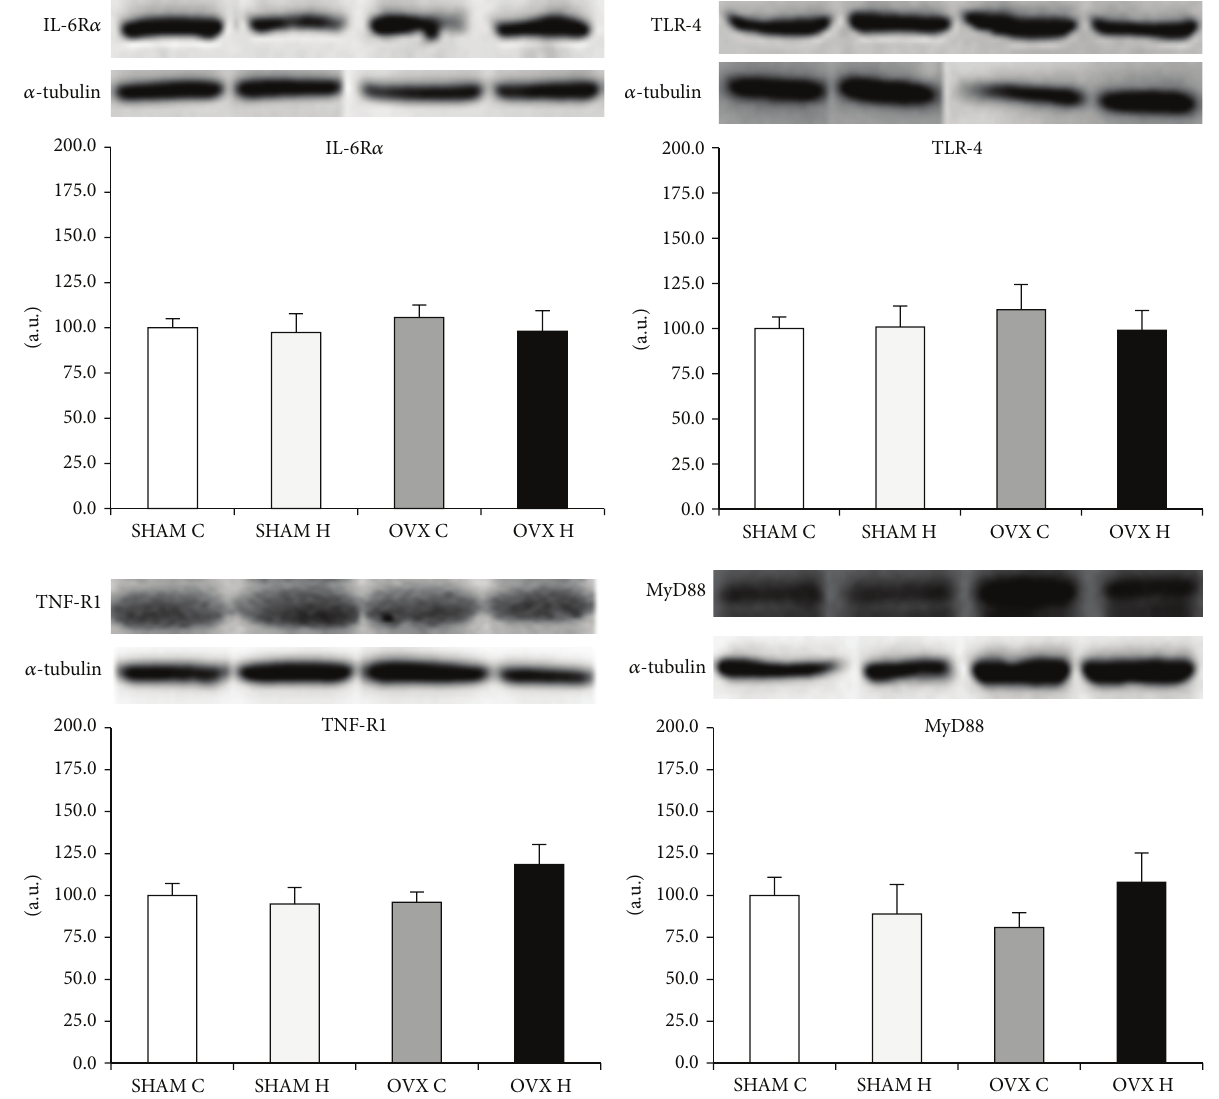
Figure 7: Gastrocnemius muscle IL-6R 𝛼 , TNF-R1, TLR-4, and MyD88 protein content: (SHAM C) sham group treated with control diet; (SHAM H) sham group treated with hyperlipidic diet; (OVX C) ovariectomized group treated with control diet; (OVX H) ovariectomized group treated with hyperlipidic